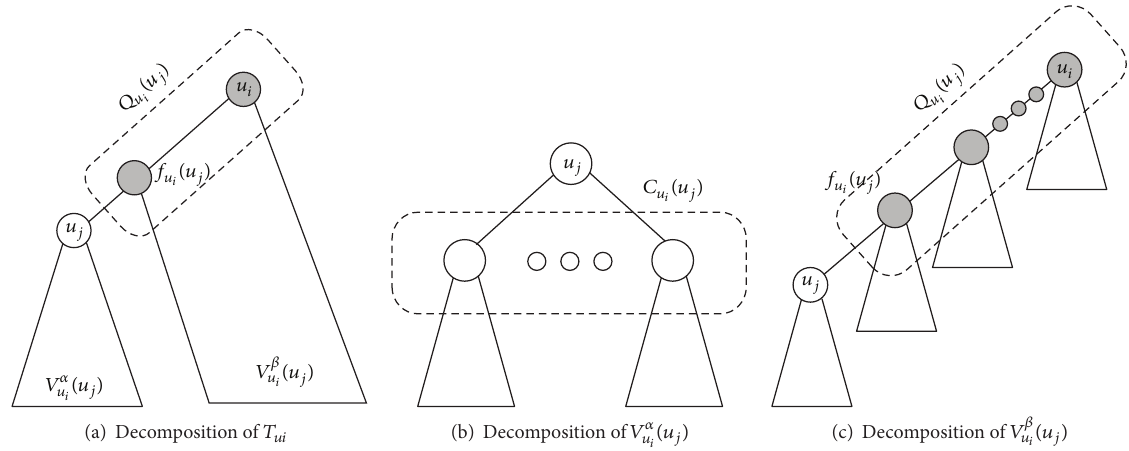
Figure 1: Illustration of the decomposition of 𝑇 𝑢